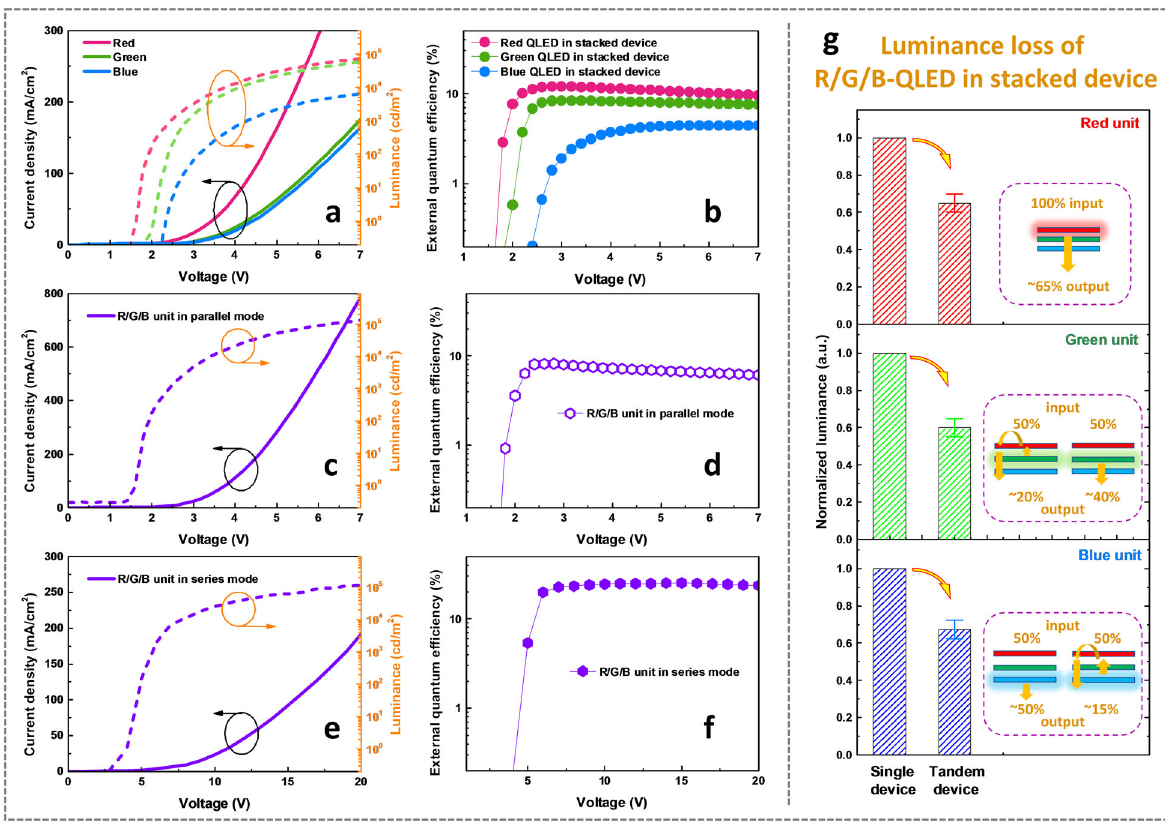
Fig. 3 Performance of the tandem QLED. a The J – V – L and b the EQE – V characteristics of the R/G/B emission in the tandem structure. The J – V – L and the EQE – V characteristics of the tandem LED operated at c , d parallel and e , f series connection mode, respectively. g Analysis of the luminance losses of the R/G/B emission in the tandem structure. Because of the absorption of the devices, the emission is attenuated when passing through each LED element. The error bar here is